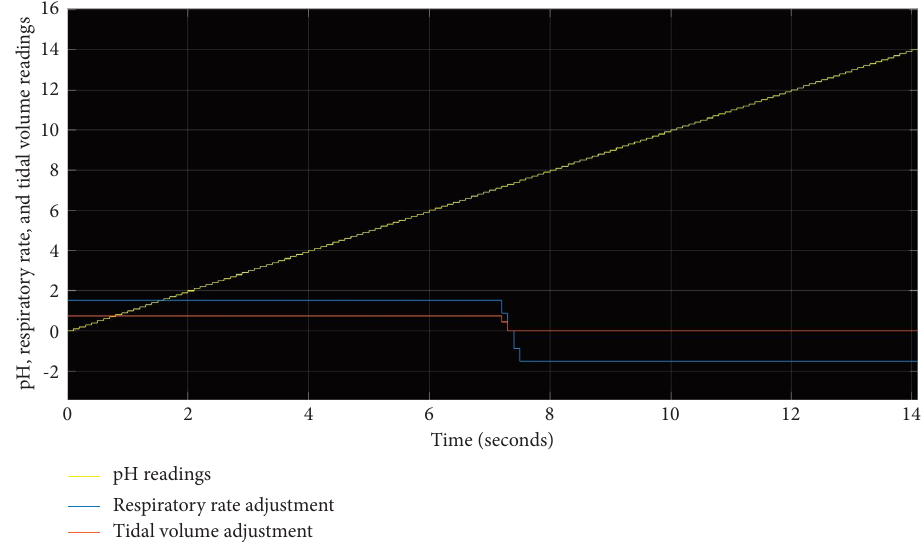
Figure 18: pH input, fuzzifed change in respiratory rate adjustment, and fuzzifed change in tidal volume adjustment